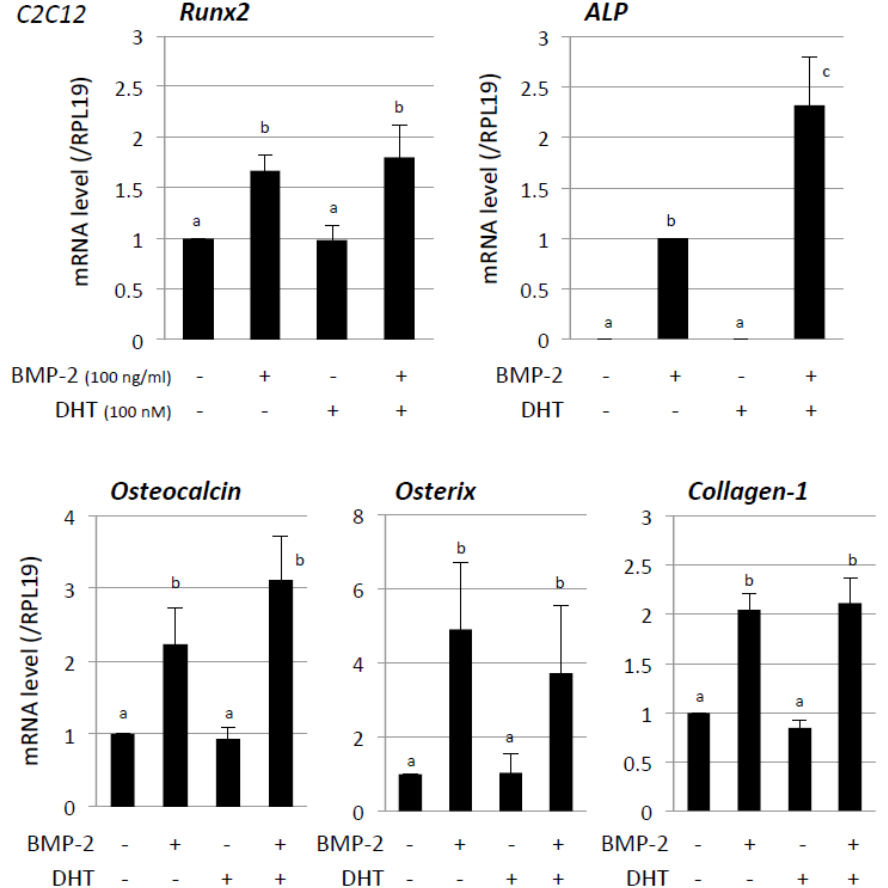
Figure 1. Effects of androgen on BMP ‐ induced osteoblast marker expression. C2C12 cells (2 × 10 5 cells/well) were treated with the indicated concentrations of DHT, GH, and BMP ‐ 2 in serum ‐ free DMEM. After 48 ‐ h culture, total cellular RNA was extracted and mRNA levels of Runx2, ALP, osteocalcin, osterix, collagen ‐ 1, and Id ‐ 1 were examined by real ‐ time RT ‐ PCR. The expression levels of target genes were standardized by RPL19 mRNA levels in each sample. Results in all panels are shown as means ± SEM of data from at least three separate experiments, each performed with triplicate samples. The results were analyzed by ANOVA. For each result within a panel, the values with different superscript letters are significantly different at p < 0.05.